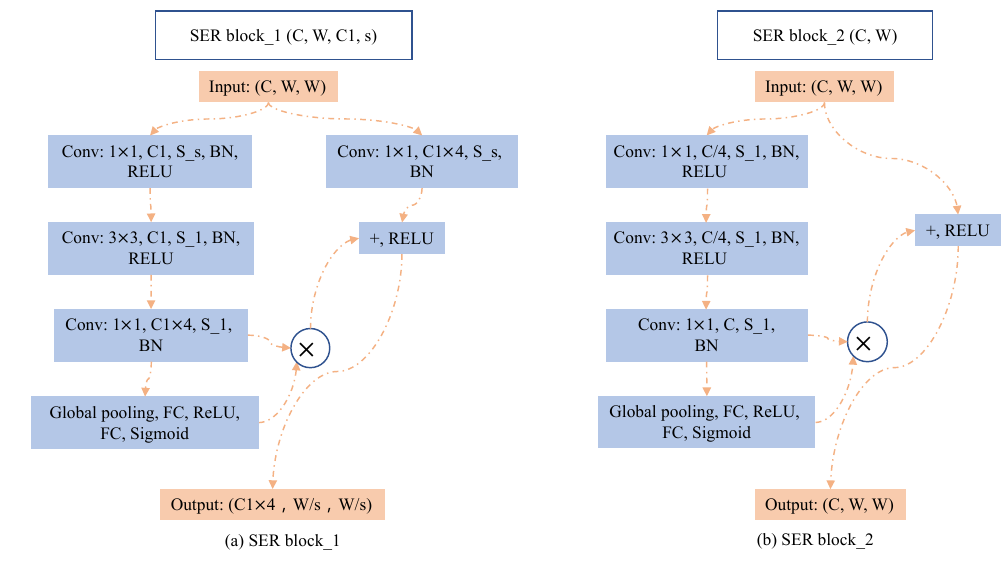
Figure 6. The backbone structure of SEM-RCNN. Red dashed box is SENet and ResNet part; blue dashed box is FPN part.